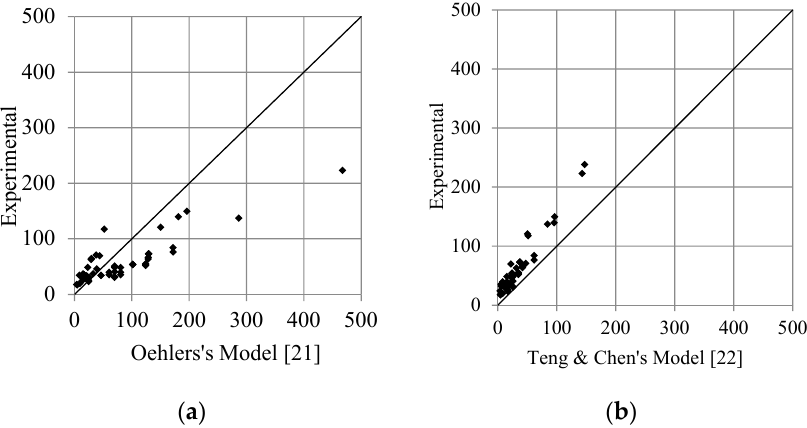
Figure 17. Comparison of the literature models of the debonding load ( a ) Oehler’s Model [21], and ( b ) Teng & Chen’s Model [22], with experimental results.